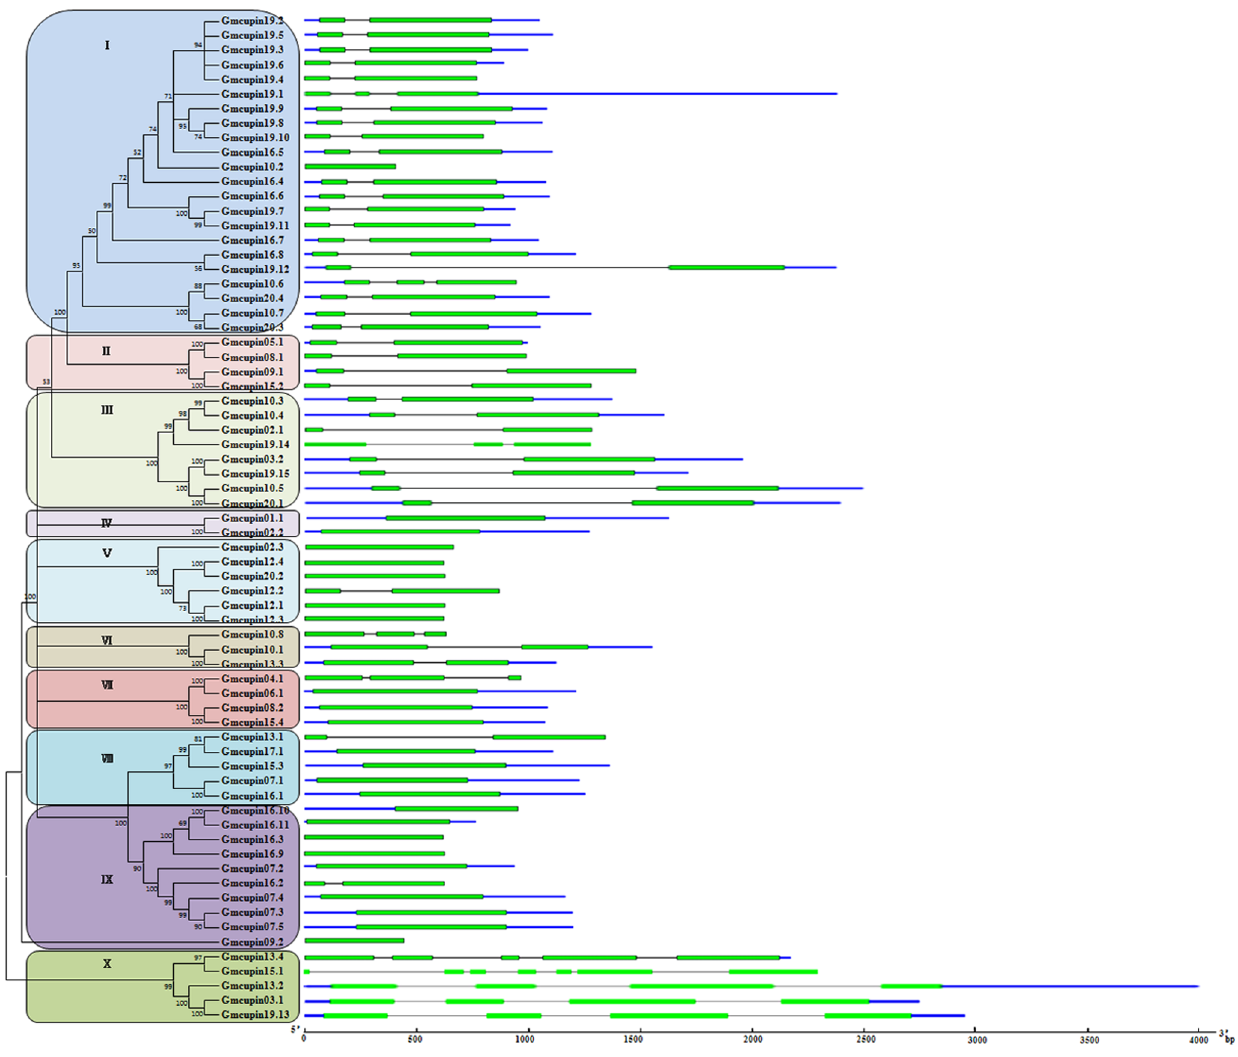
Figure 2. Phylogenetic relationships and gene structure of Gmcupin genes. The phylogenetic tree of Gmcupin proteins constructed from a complete alignment of 69 Gmcupin proteins using MEGA 5.0 by the neighbor-joining method. The bootstrap consensus tree inferred from 1000 replicates is taken to represent the evolutionary history of the taxa analyzed. Percentage bootstrap scores of . 50% are indicated on the nodes. Ten major phylogenetic subgroups (designated as I to X) are indicated. Exons of Gmcupin genes are represented by green boxes and introns and untranslated region (UTR) by black and blue lines. The sizes of exons and introns can be estimated using the scale below.